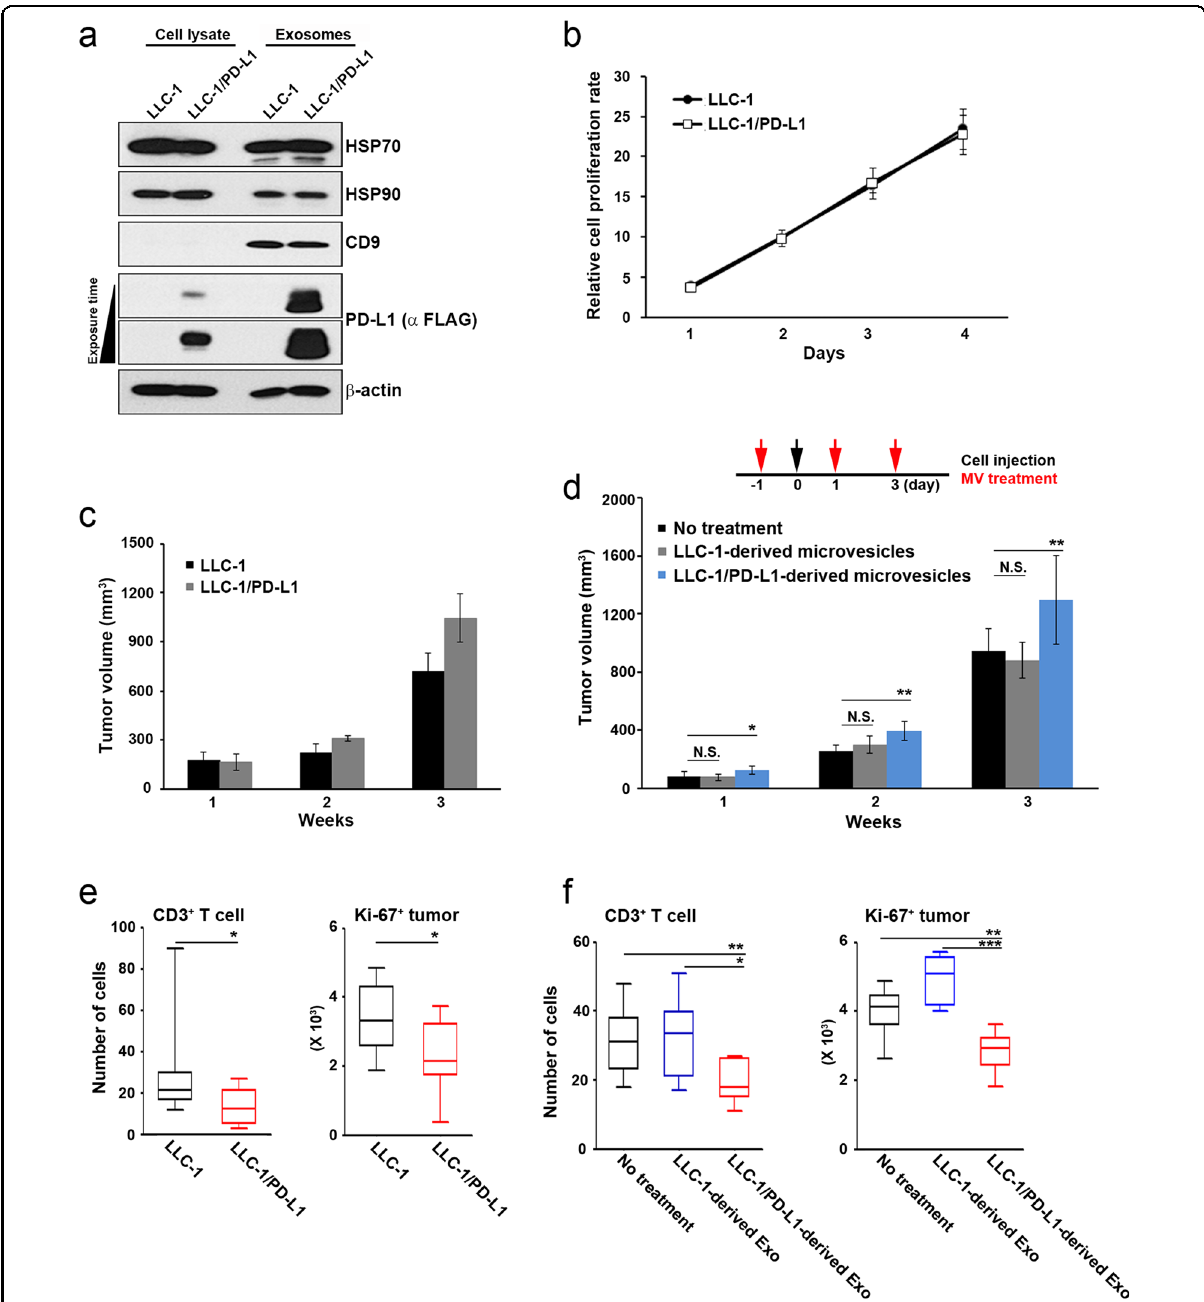
Fig. 4 The effect of PD-L1-containing exosomes on tumor growth in vivo. a Production of mPD-L1-containing exosomes by LLC-1 cells. Stable LLC-1/PD-L1 cells were generated by infection with pGIPZ-shmPD-L1/Flag-mPD-L1. PD-L1 expression levels in cell lysates (10 μ g) and exosomes (10 μ g) were determined by western blot analysis. b The cell proliferation rate was measured using a cell counter. c A xenograft tumor model was established by injecting LLC-1 or LLC-1/PD-L1 cells into the fl ank region of mice ( n = 10). d Exosomes (50 μ g 100 μ L – 1 ) were injected into the tail vein of mice ( n = 10) three times before and after the injection of LLC-1 cells. Tumor volumes were measured on the indicated day. e , f The numbers of tumor-in fi ltrating T cells (CD3 + cells) and proliferating tumor cells (Ki-67 + cells) were counted by using multiplex immuno fl uorescence in tumors harvested from the tumor-bearing mice described in ( c ) and ( d ). All data are presented as the means ± standard deviations. * P < 0.05 and ** P < 0.005 by a paired two-tailed Student ’ s t